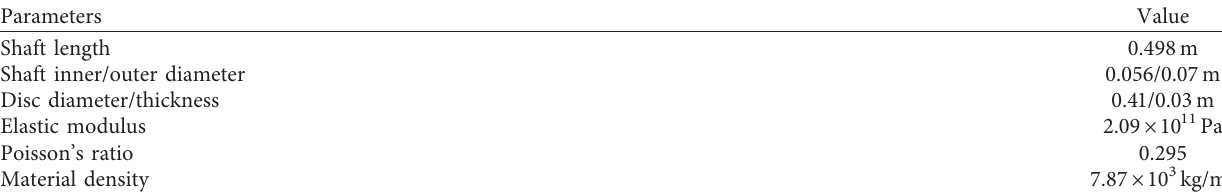
Figure 1: Scaled test rig. (a) Photo of the scaled test rig. (b) Cross-view of the support structure. Table 1: Parameters of the scaled test rig.